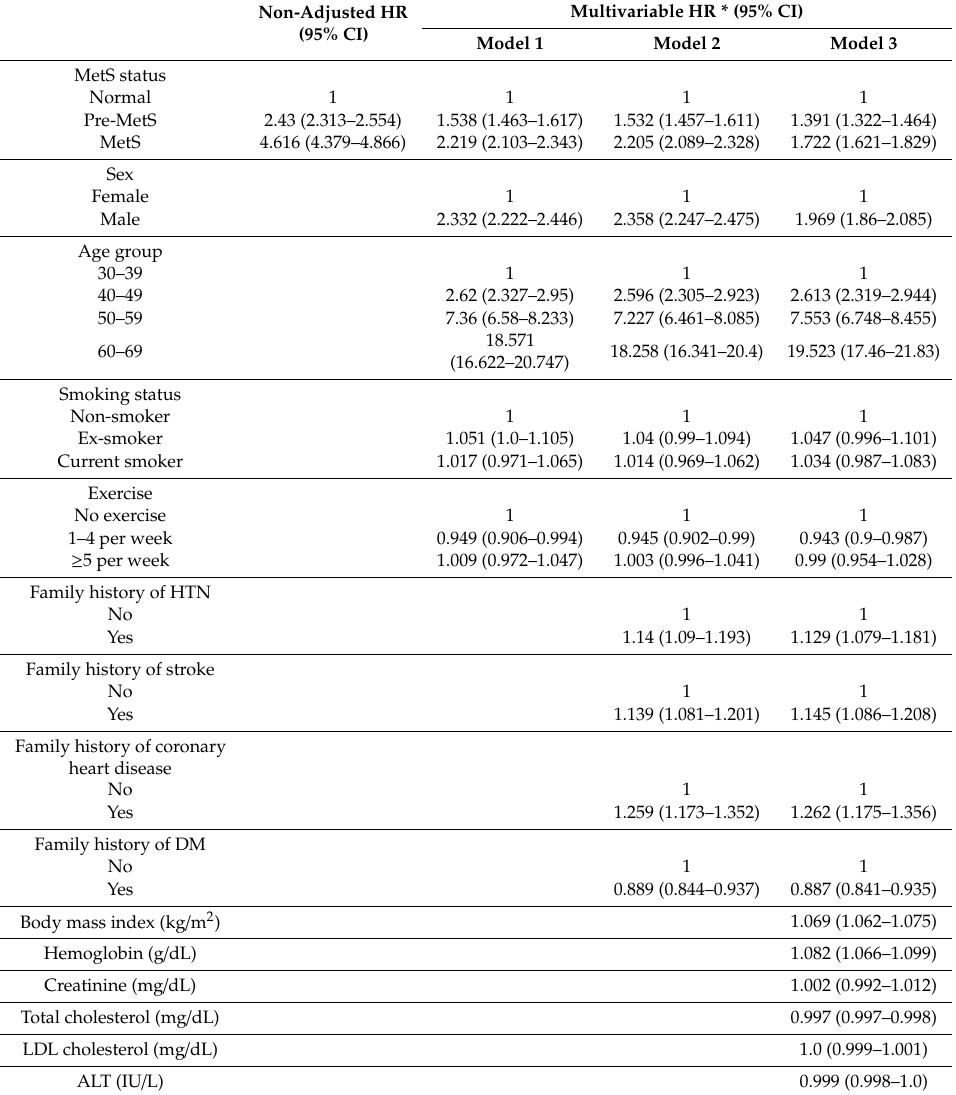
Table 3. Risk of atrial fibrillation: Cox proportional hazard model.